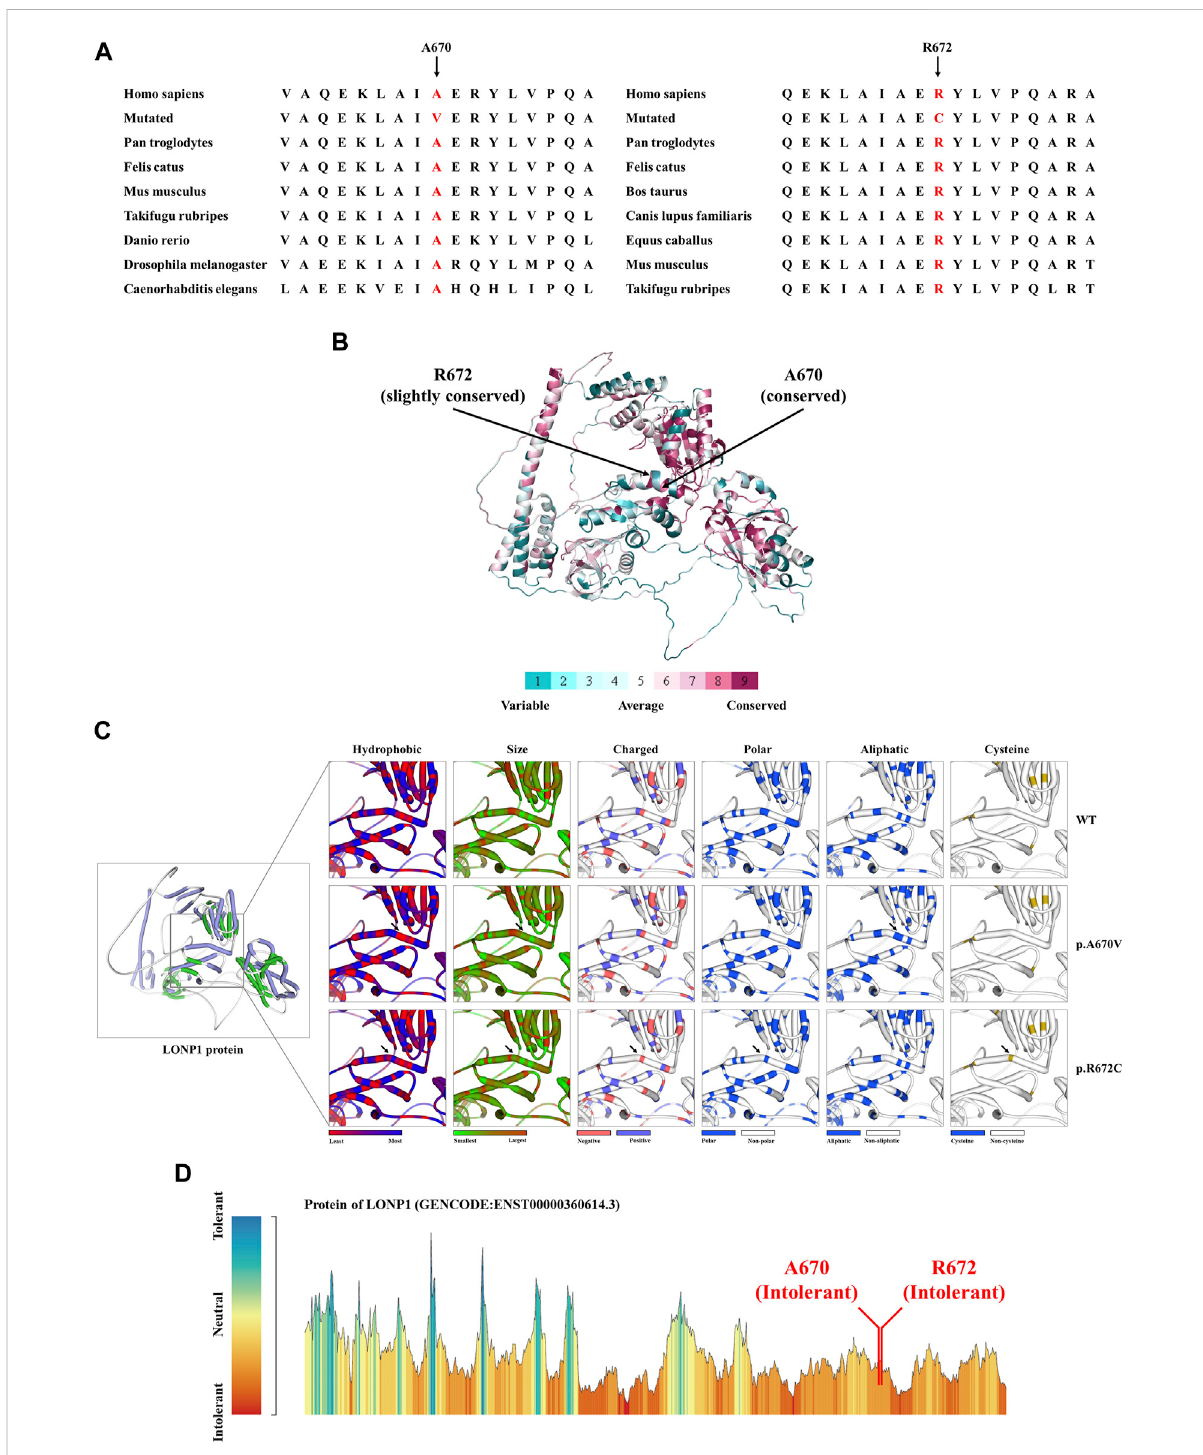
FIGURE 2 The bioinformatics analysis of mutations. (A) Alignment of multiple LONP1 protein sequences across species. Letters in red show both the A670 site and the R672 are evolutionarily conserved. (B) The conservation analysis of the A670 site and the R672 amino acids were predicted by ConSurf Server software. (C) Structure prediction of wild type protein and mutant proteins. The wild type LONP1 (LONP1-WT) protein structure, the p.A670V mutant LONP1 (LONP1-p.A670V) protein structure and the p.R672C mutant LONP1 (LONP1-p.R672C) protein structure were predicted by SWISS-MODEL online software. Black arrows show the changes of LONP1 protein. (D) MetaDome server was used to identify the intolerant regions in DES. As depicted, the affected nucleotides/residues are located in an intolerant